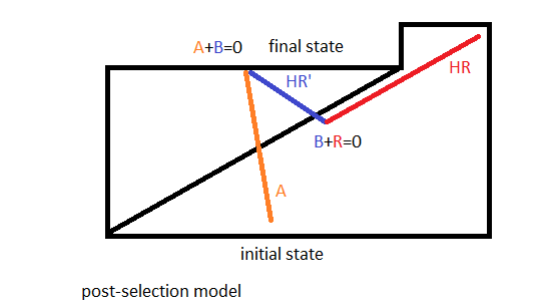
Figure 3. Black hole final